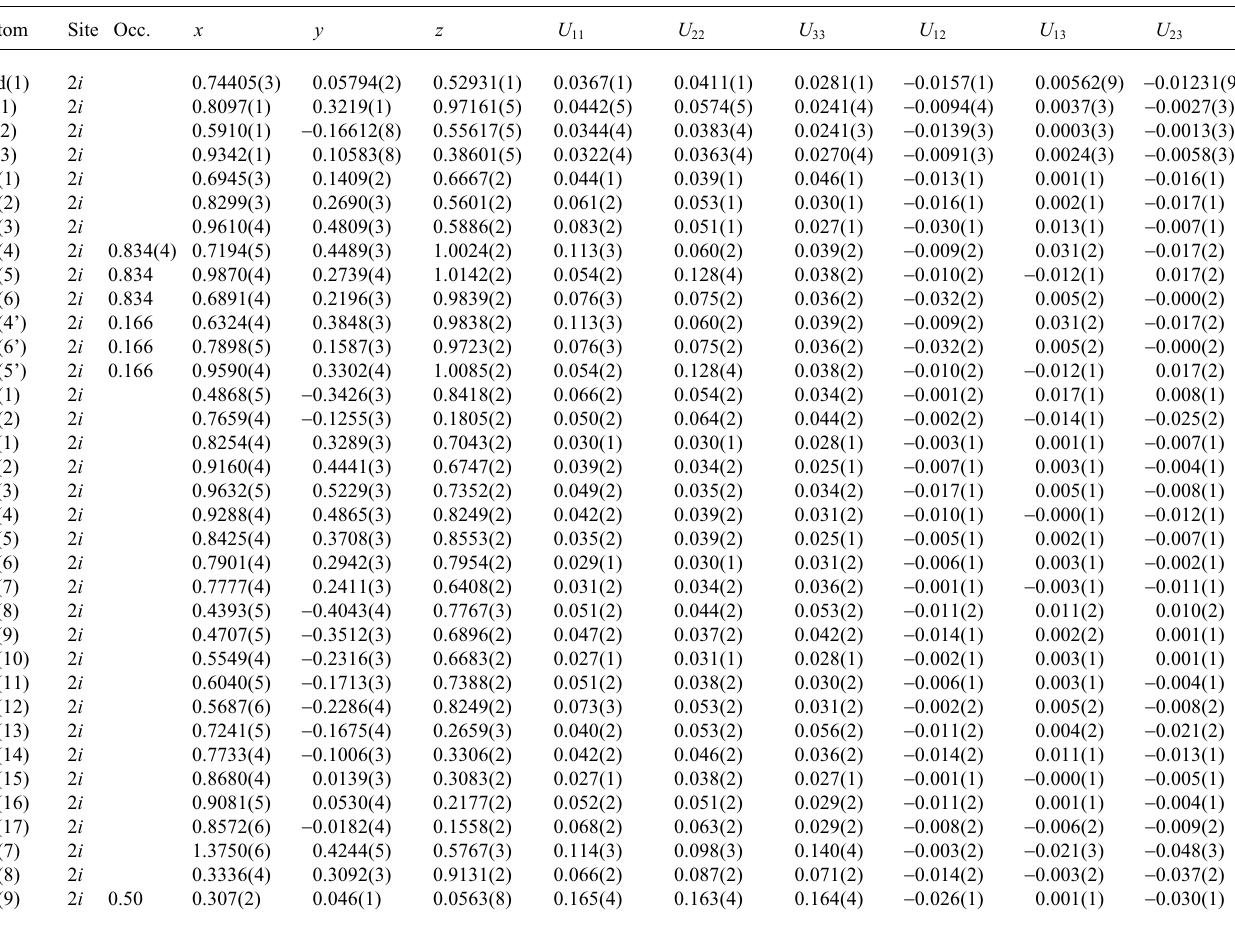
Table 3. Atomic coordinates and displacement parameters (in Å 2 )